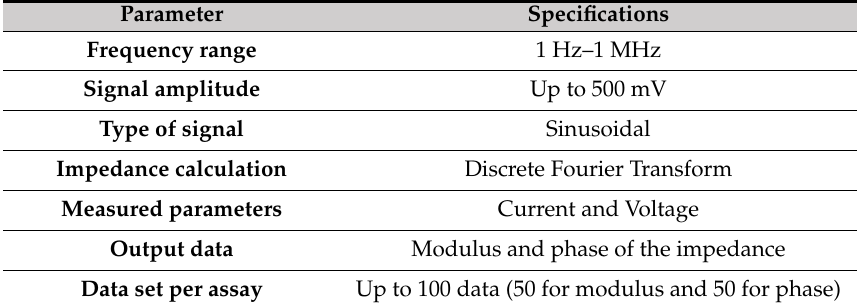
Figure 2. Electrochemical impedance spectroscopy system. Table 1. Specifications of the electrochemical impedance spectroscopy (EIS) measurement system.